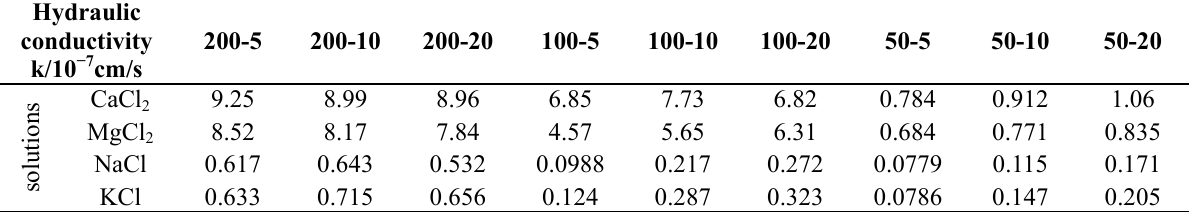
Table 3. Hydraulic conductivity of GCL specimens in each working condition.